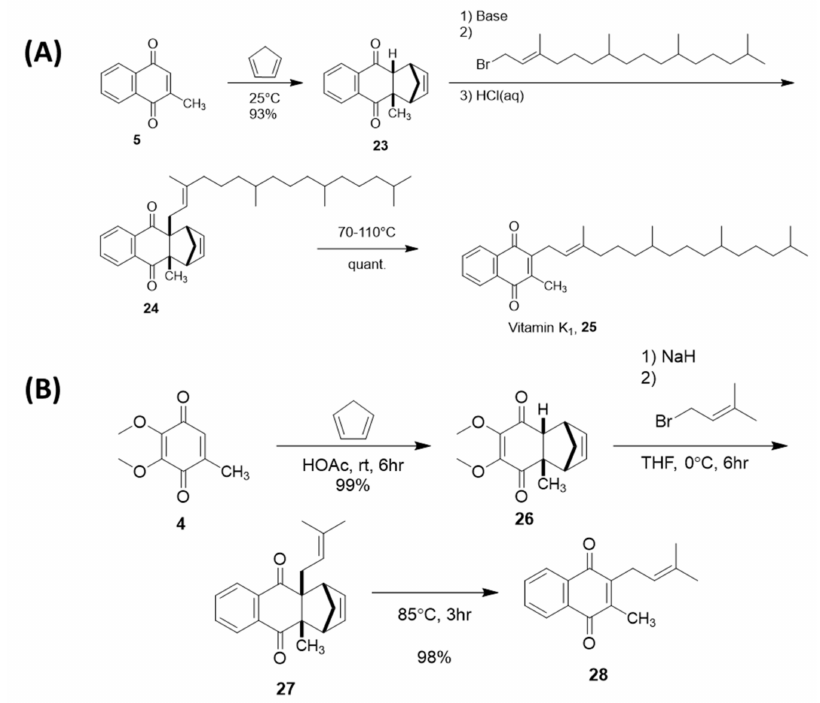
Scheme 6. Examples of Diels − Alder reactions being used to control the regioselectivity of the sidechain installation. ( A ) Synthesis of vitamin K1 [128,129]. ( B ) Synthesis of UQ-1